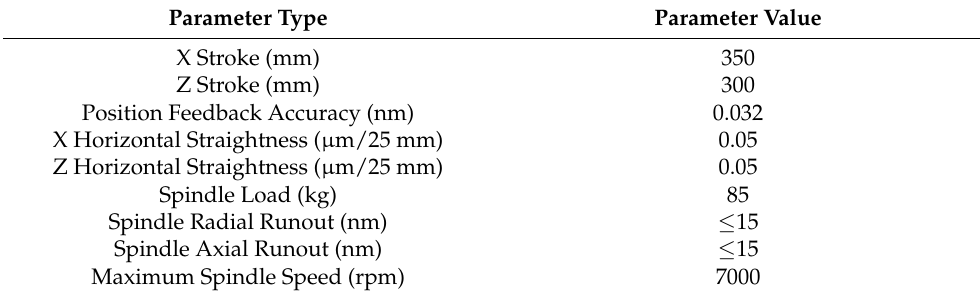
Figure 7. The processed spherical shell: ( a ) the outer surface; ( b ) the inner surface. Table 1. The machine parameters.